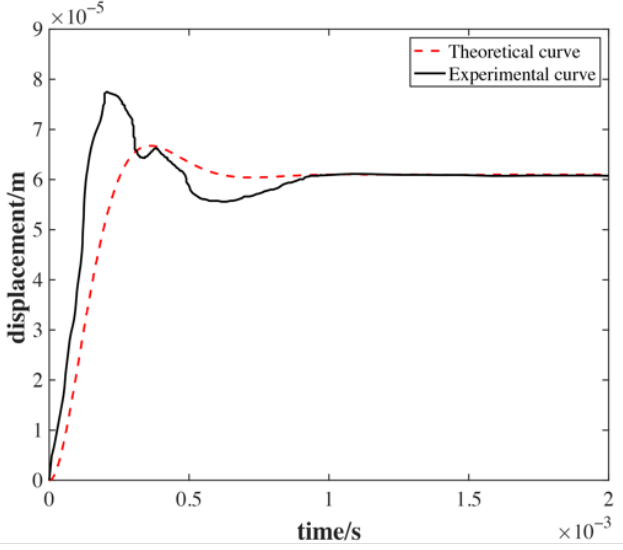
Figure 4. Experimental and theoretical curves of step response of the GMA.